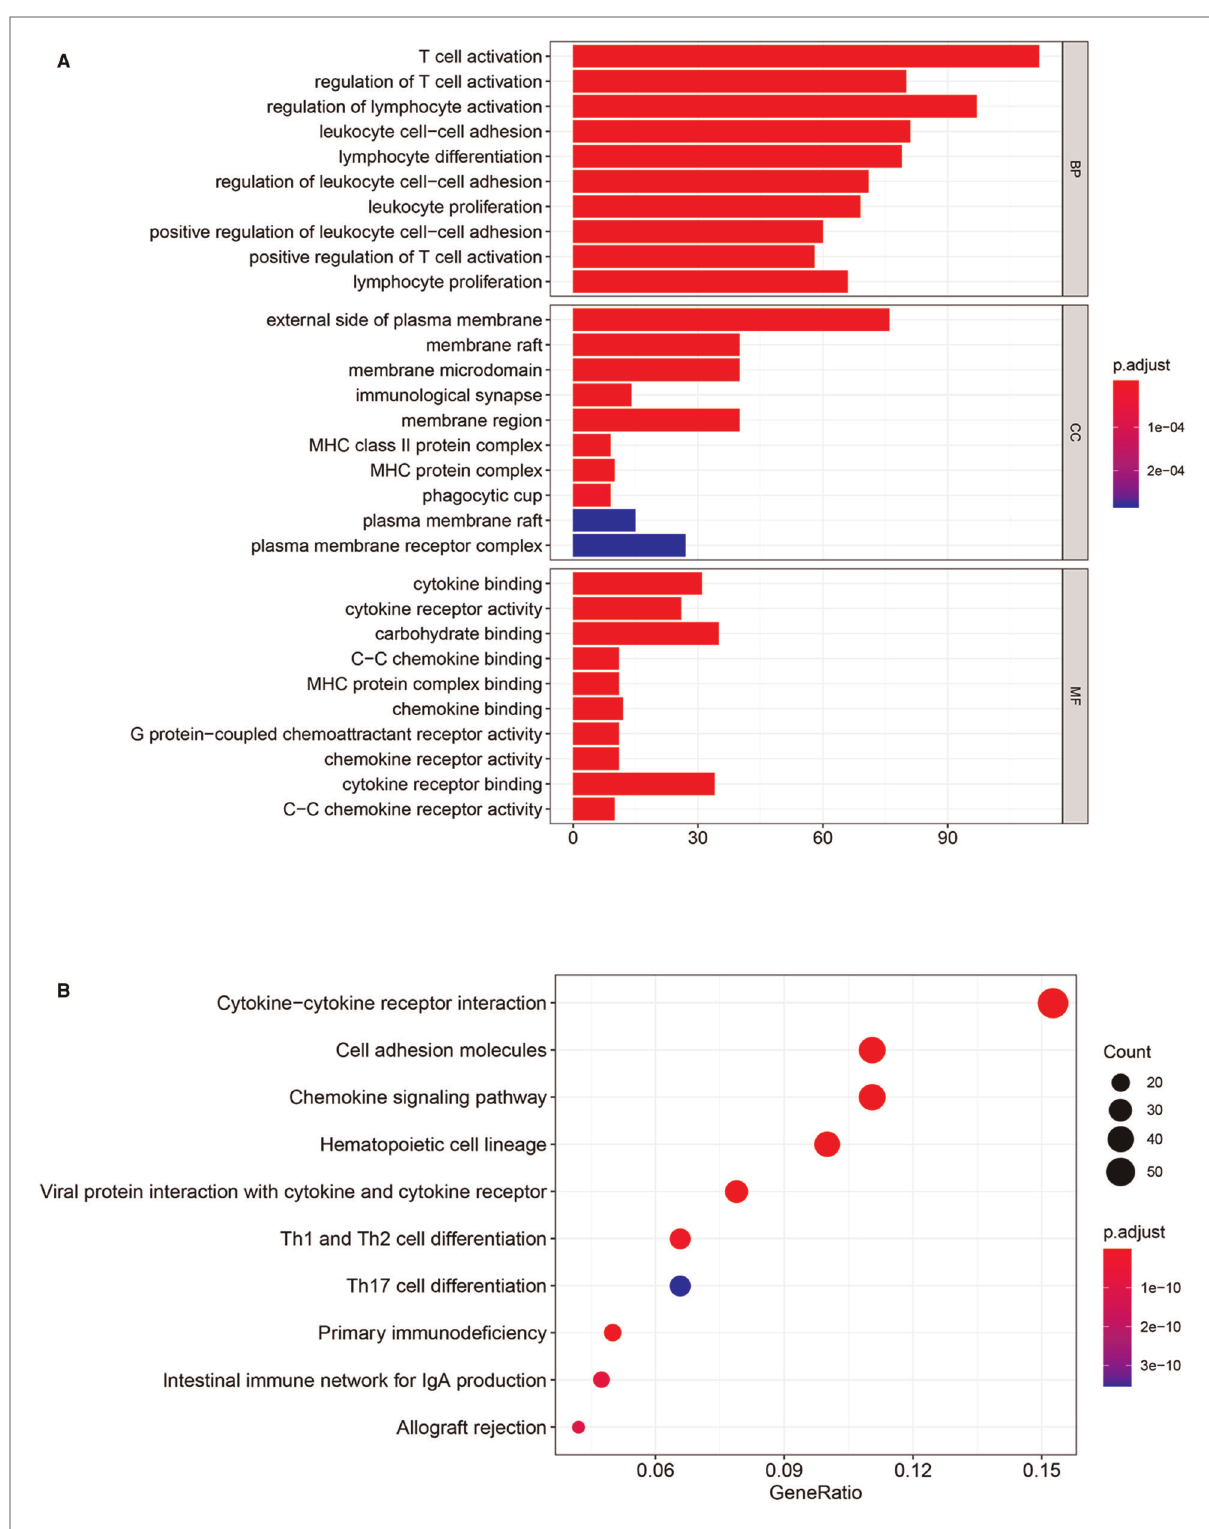
FIGURE 5 CCDC69 was involved in BC immune response. GO ( A ) and KEGG ( B ) analysis of 1,108 BC samples with CCDC69 expression levels showed that the genes positively co-expressed with CCDC69 were mainly related to immune